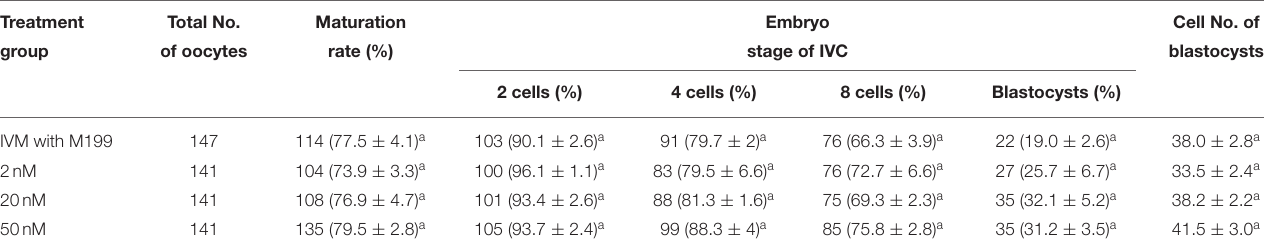
TABLE 7 | Effects of IVM media supplemented with miR-22-3p on the development of parthenogenetic activation porcine embryos. Treatment Total No. Maturation Embryo Cell No. of